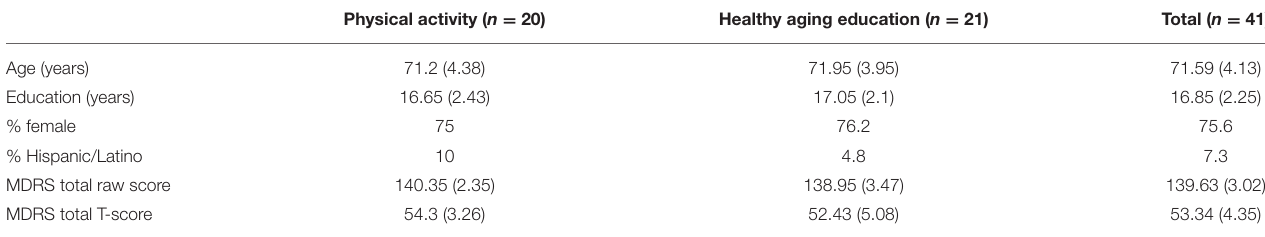
TABLE 1 | Participant